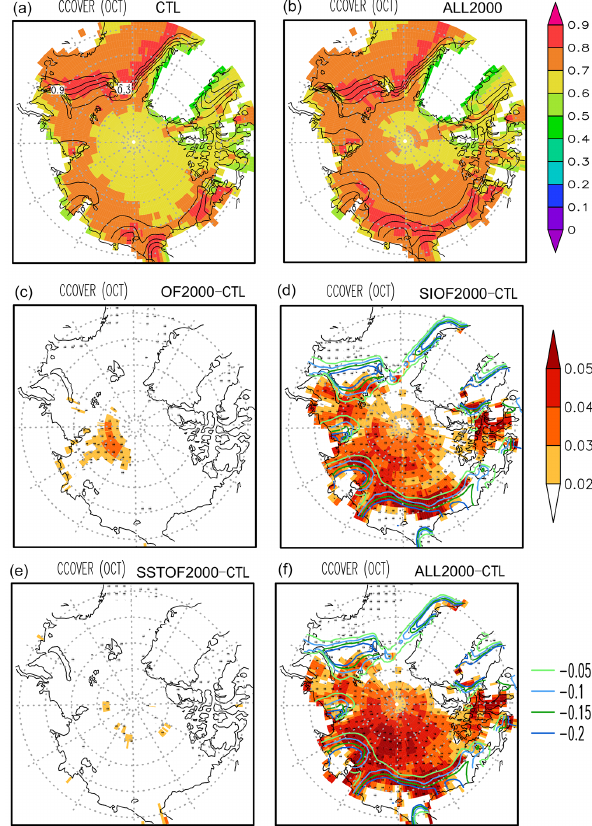
Figure 6. Geographical map of the total cloud cover (shaded) and sea ice concentration (contours) in October in the sensitivity exper- iments and the differences between